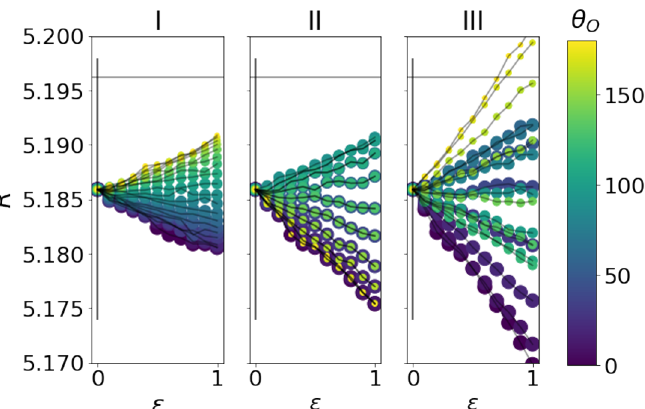
Figure 10 . Average radii ¯ R of the shadows for three types of soft hair functions given in (4.8)–(4.10) with 0 ≤ E ≤ 1 . The long vertical line indicates the numerical error bar ± 0 . 012 , within which our numerical value ¯ R 0 ’ 5 . 186 for the Schwarzschild case is consistent with the theoretical one, √ 27 ’ 5 . 196 , as denoted by the horizontal line. The color bar indicates the observer’s inclination angle 0 ◦ ≤ θ O ≤ 180 ◦ . There are degeneracies of ¯ R for different inclination angles, which will then be indicated by the solid lines. Overall, the results show |